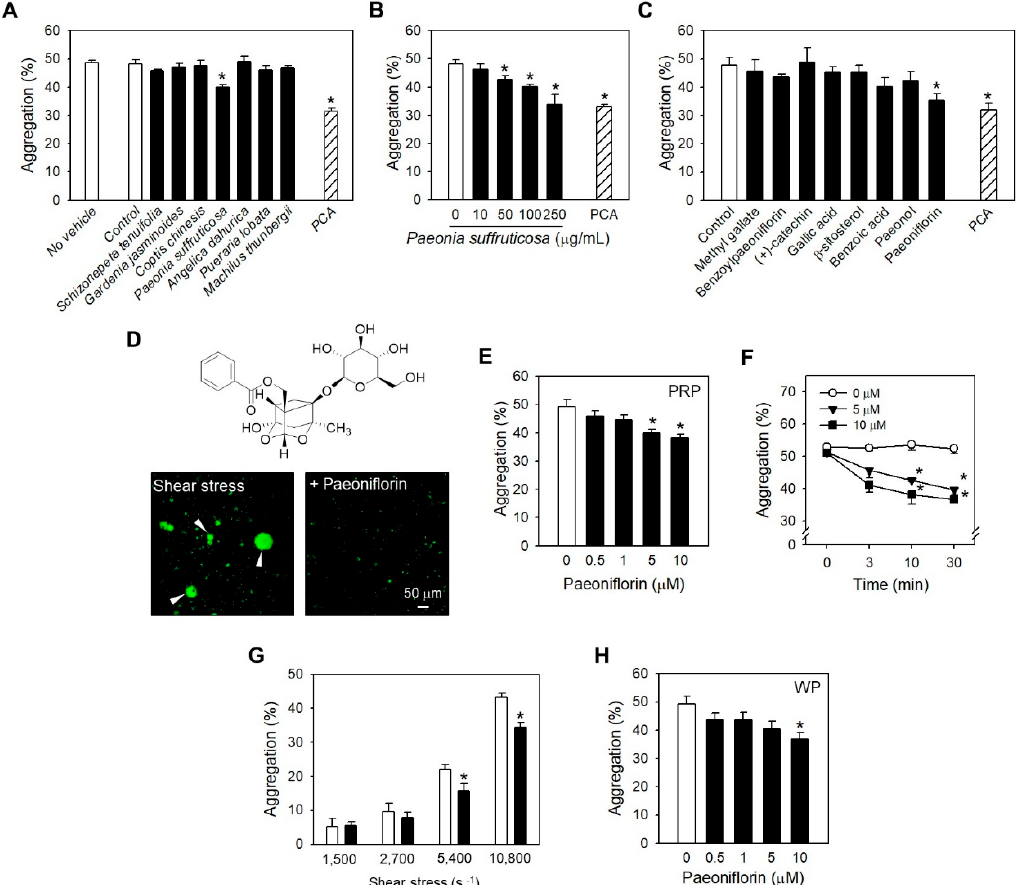
Figure 1. Inhibitory effects of Paeonia suffruticosa extract and paeoniflorin on shear stress-induced platelet aggregation (SIPA). ( A ) Effects of herbal extracts (100 µg/mL) on SIPA in human platelet-rich-plasma (PRP) ( n = 3). ( B ) Concentration-dependent effects of Paeonia suffruticosa extract on SIPA ( n = 3). ( C ) Effects of the active ingredients of Paeonia suffruticosa (25 µM) on SIPA in PRP ( n = 3). Insert,